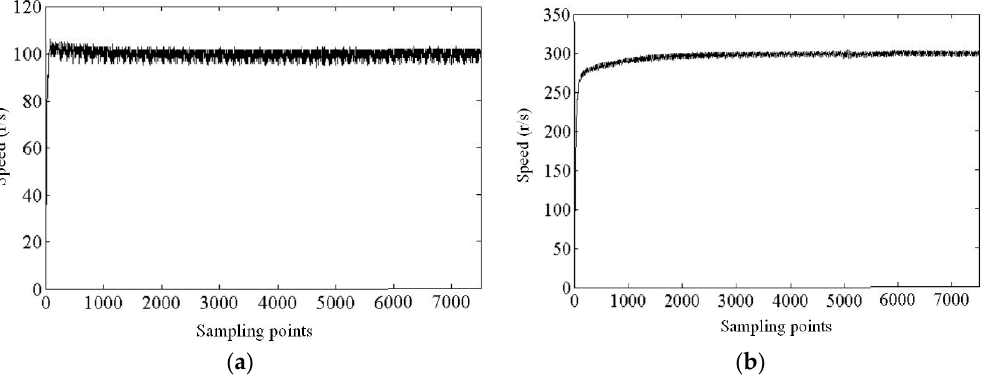
/100 =ω /100 =ω r /100 =ω r r